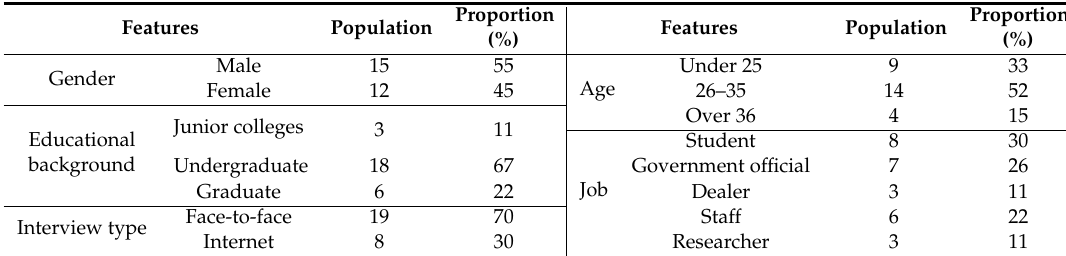
Table 1. Characteristics of 27